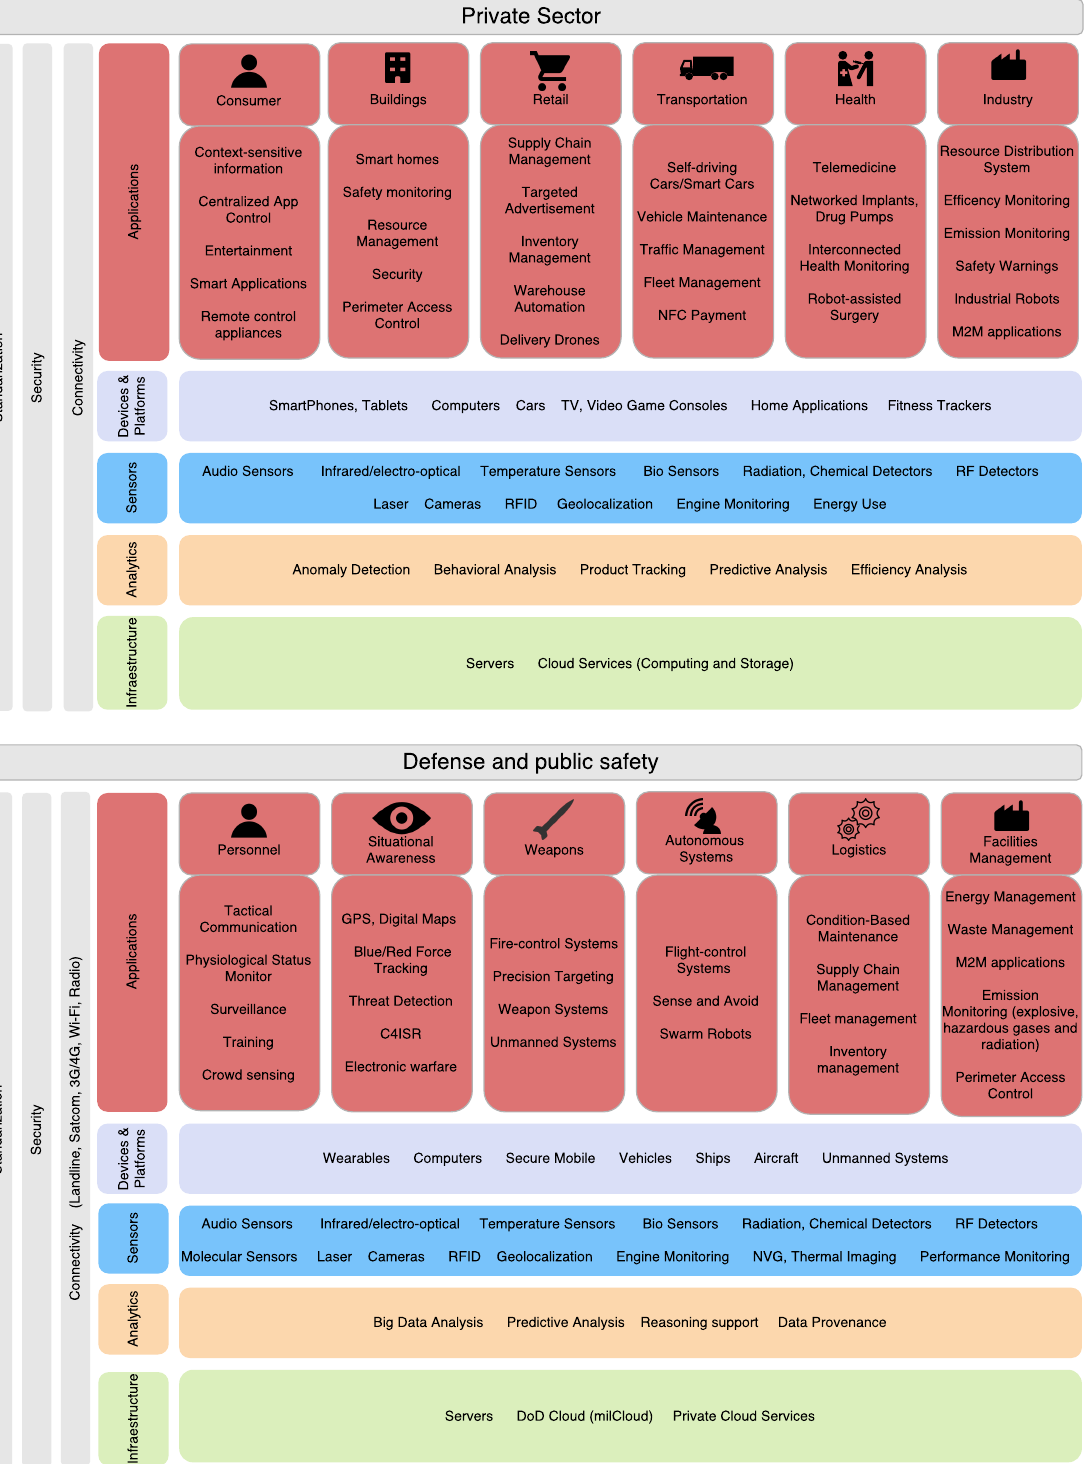
Figure 2. Private sector vs defense and public safety technology